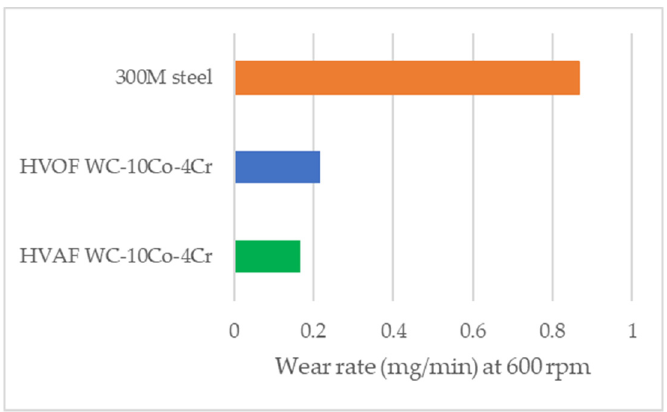
Figure 10. Wear rate of HVAF and HVOF WC-10Co-4Cr coating and 300M steel substrate, adopted from Liu et al. [146].